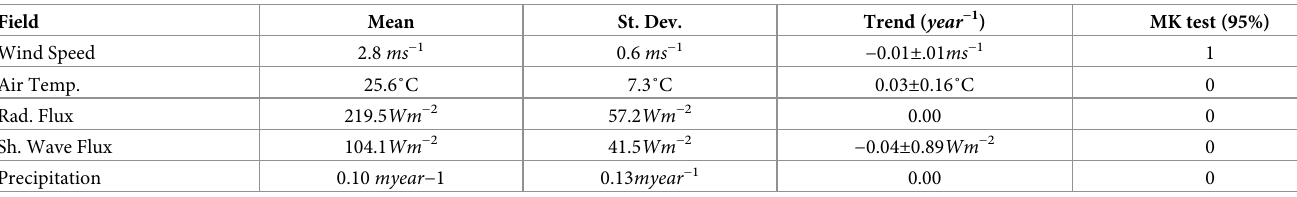
Table 1. NCEP forcing fields statistics for the period 1980 to 2013.